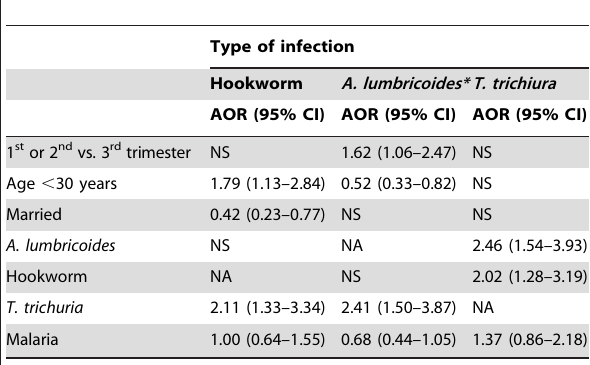
Table 3. Factors associated with type of geohelminth infection in multivariate analysis among pregnant women, Gem, July